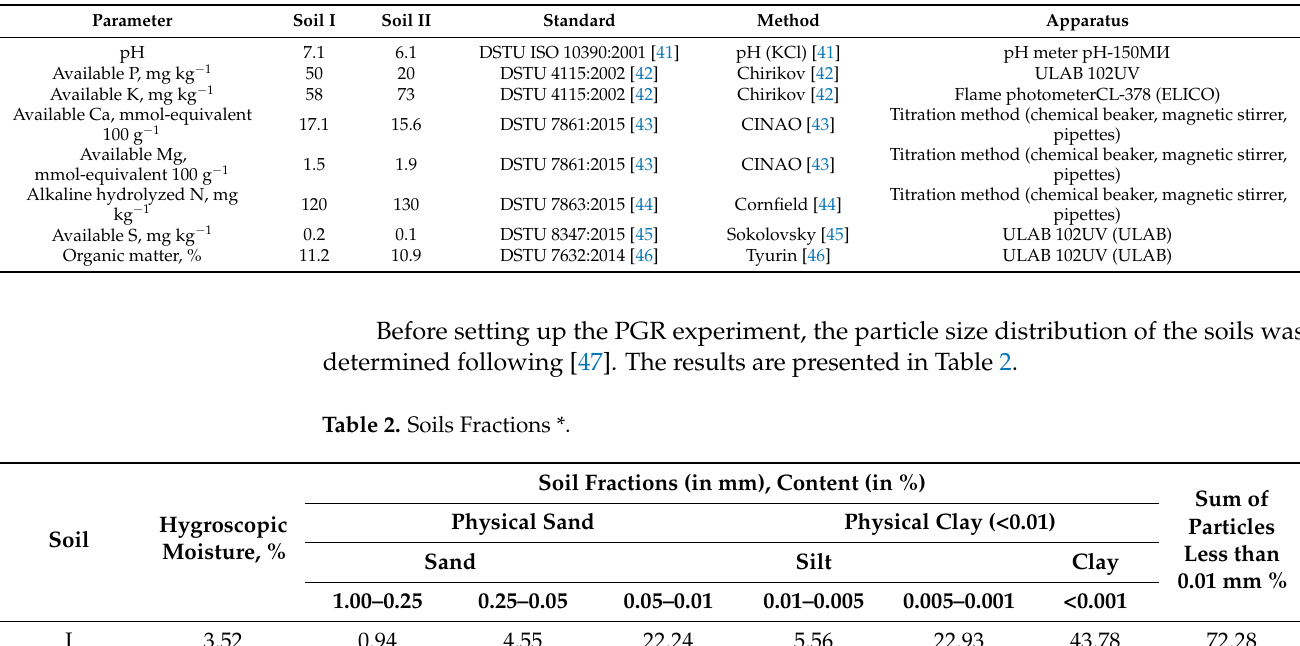
Table 1. Agrochemical characteristics of Soil I and Soil II.